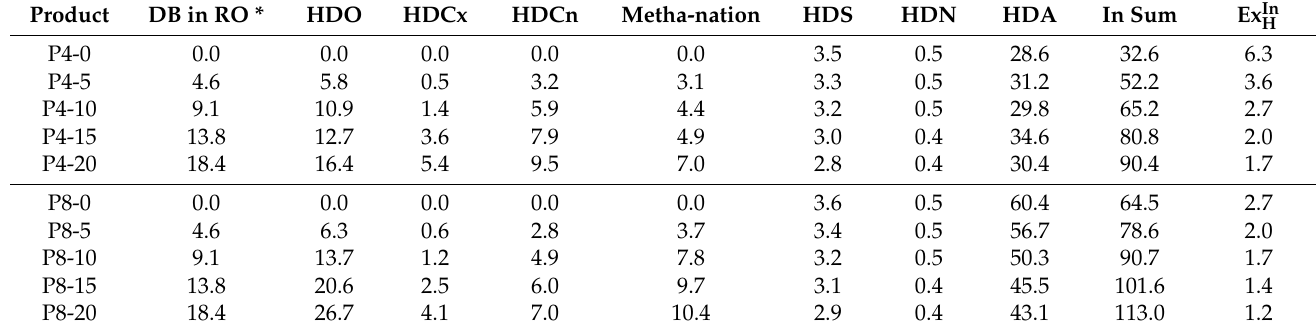
Figure 5. Share of the HDO ( A ), HDCx ( B ) and HDCn ( C ) in the RO conversion and share of the CO converted by methanation ( D ). Table 7. The hydrogen consumption (m 3 · m − 3 ) for the individual reactions, the total hydrogen consumption (in sum), and excess hydrogen at the inlet of the reactor in the hydrotreated (Ex In ) H